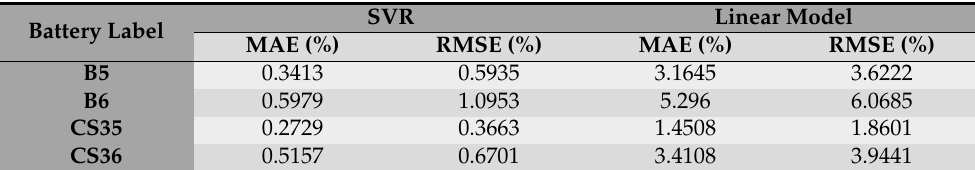
Table 3. Results of the